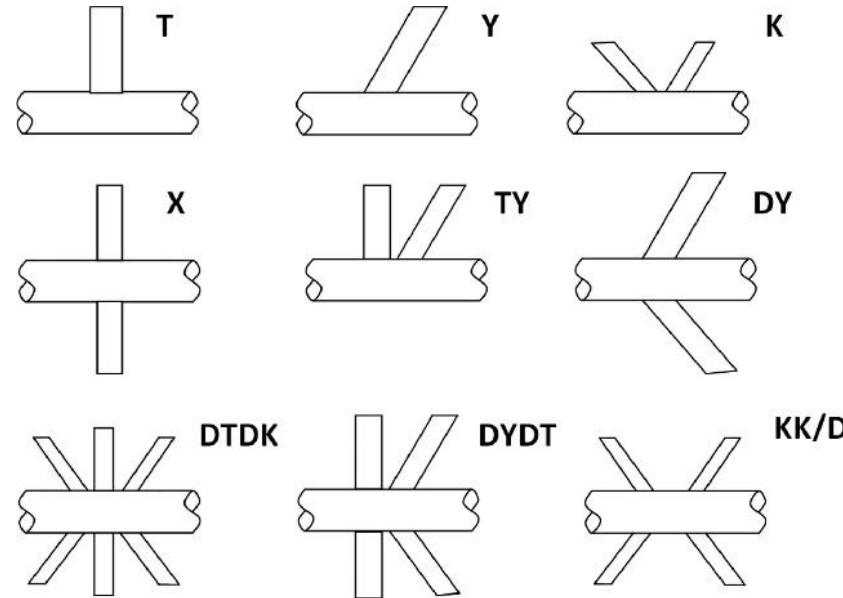
Figure 1. Typical tubular joints in offshore structures (no permission required, under CC BY-NC- ND license) [1] .